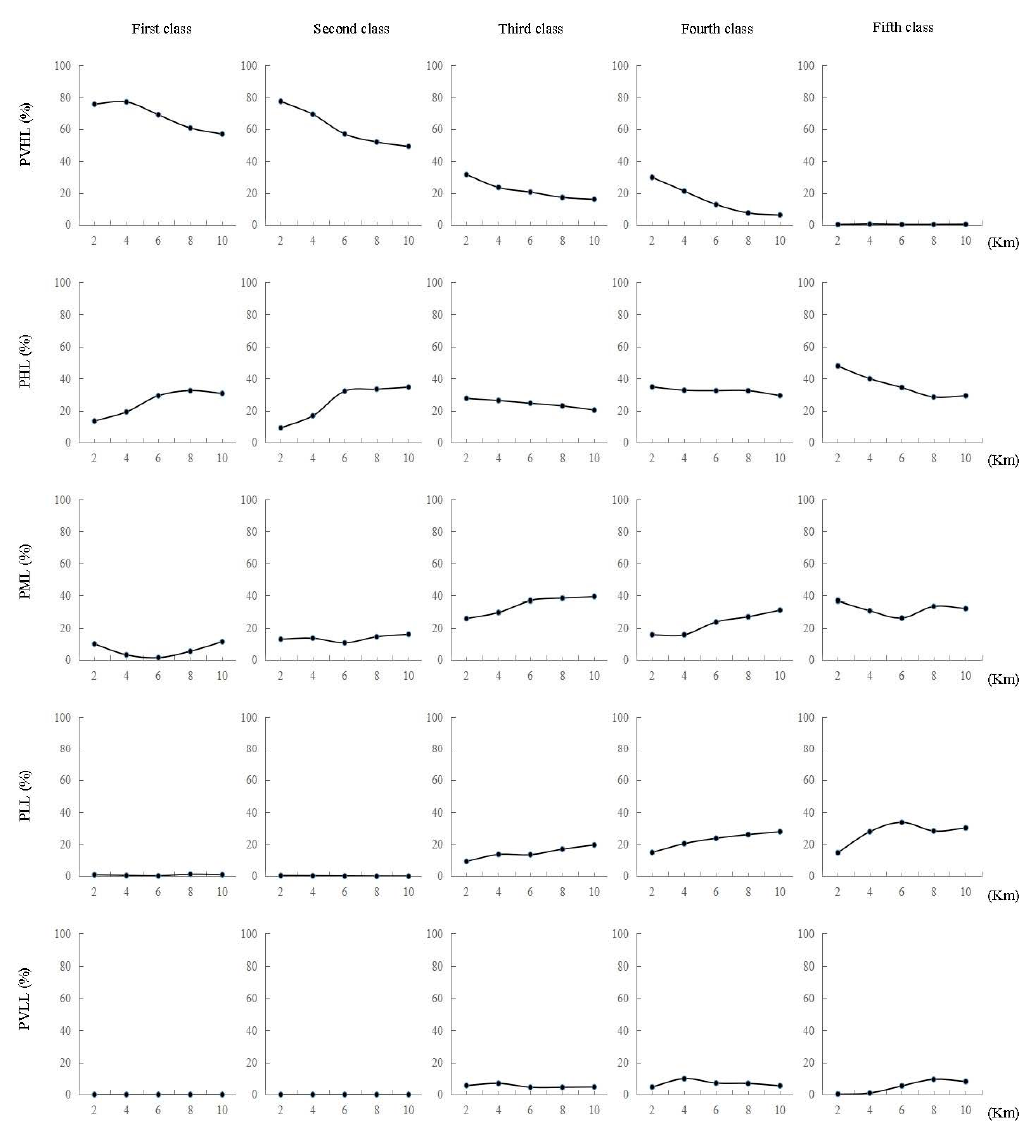
Figure 3. Percentage of restoration suitability in different river orders and buffer zones within different distances (PVHL means percentage of very high level; PHL means percentage of high level; PML means percentage of moderate level; PLL means percentage of low level; PVLL means percentage of very low level).